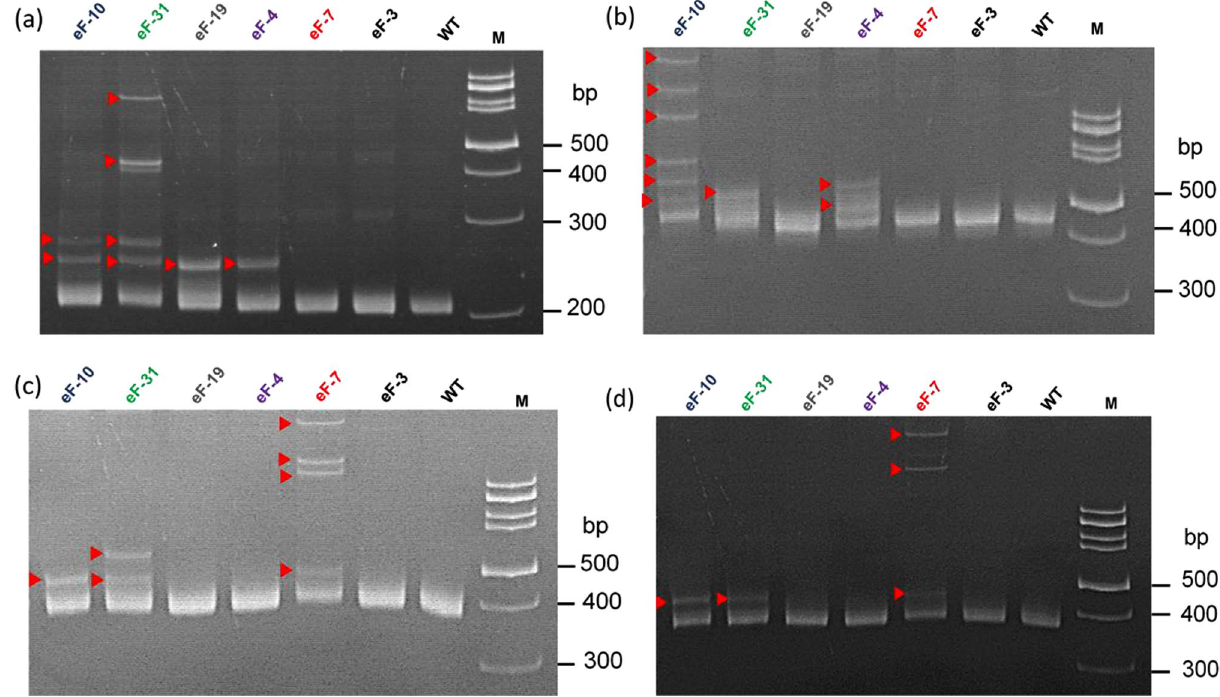
WT ACCTAAGCATCCATTA-GAGAATTCTTGGACTTTTTGGTTTGATAATCC 0 eF-10-a ACCTAAGCATCCATTA--AGAATTCTTGGACTTTTTGGTTTGATAATCC -1 (4/10) eF-10-b ACCTAAGCATCCATTAAGAGAATTCTTGGACTTTTTGGTTTGATAATCC +1 (6/10) eF-31-a ACCTAAGCATCCATTA----AATTCTTGGACTTTTTGGTTTGATAATCC -3 (8/10) eF-31-b ACCTAAGCATCCATTAAGAGAATTCTTGGACTTTTTGGTTTGATAATCC +1 (2/10) eF-19-a ACCTAAGCATCCATTAAGAGAATTCTTGGACTTTTTGGTTTGATAATCC +1 (4/10) eF-19-b ACCTAAGCATCCATTATGAGAATTCTTGGACTTTTTGGTTTGATAATCC +1 (6/10) eF-4-a ACCTAAGCATCCATTA-GAGAATTCTTGGACTTTTTGGTTTGATAATCC 0 (3/10) eF-4-b ACCTAAGCATCCATTAAGAGAATTCTTGGACTTTTTGGTTTGATAATCC +1 (7/10) ACCTAAGCATCCATTA-GAGAATTCTTGGACTTTTTGGTTTGATAATCC 0 (7/7) eF-3 ACCTAAGCATCCATTA-GAGAATTCTTGGACTTTTTGGTTTGATAATCC 0 (8/8)